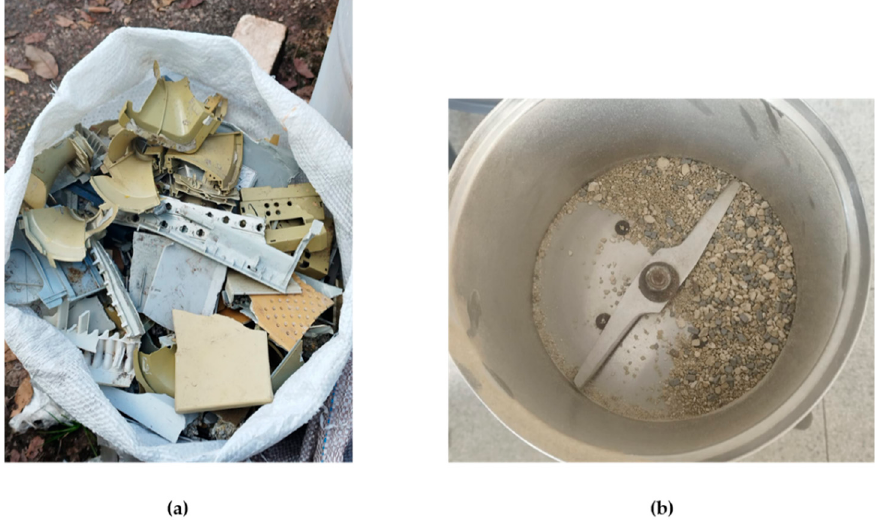
Figure 3. WEEE plastic before ( a ) and after grinding ( b ). Table 1. Specifications of commercial grade carbon pellets for